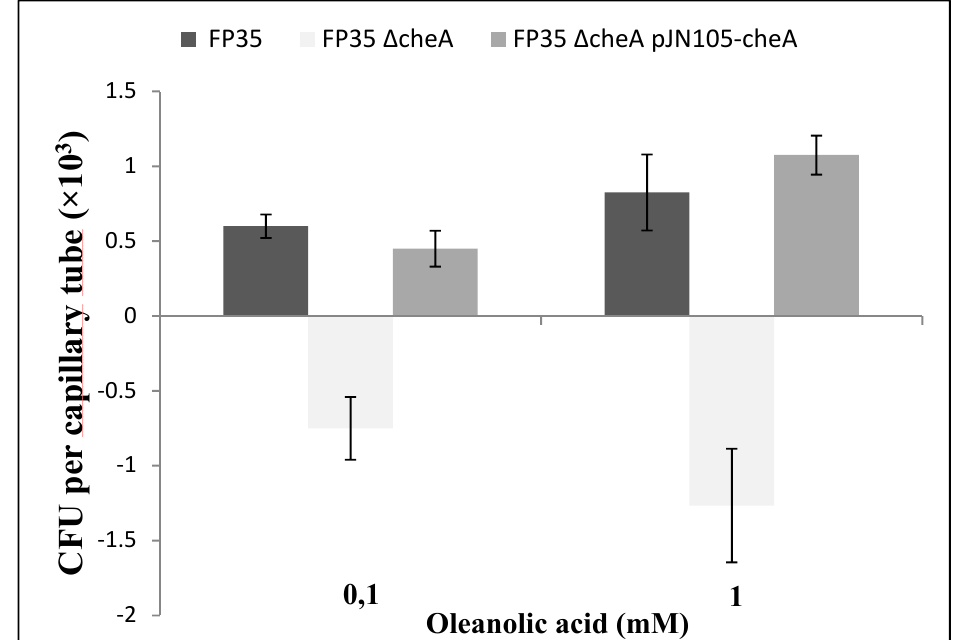
Figure 6. Quantitative capillary chemotaxis assays comparing responses of wild-type H. anticariensis FP35 T and its mutant strains FP35 ∆ cheA and FP35 ∆ cheA pJN105-cheA, grown in 5% (w / v) sea salt solution, to oleanolic acid. The results represent the mean of three independent biological samples performed in triplicate, with error bars indicating standard errors. The graph shows the increase in CFU in capillaries normalized by the negative control (CB). The negative values for CFUs in the capillaries reflect negative chemotaxis.